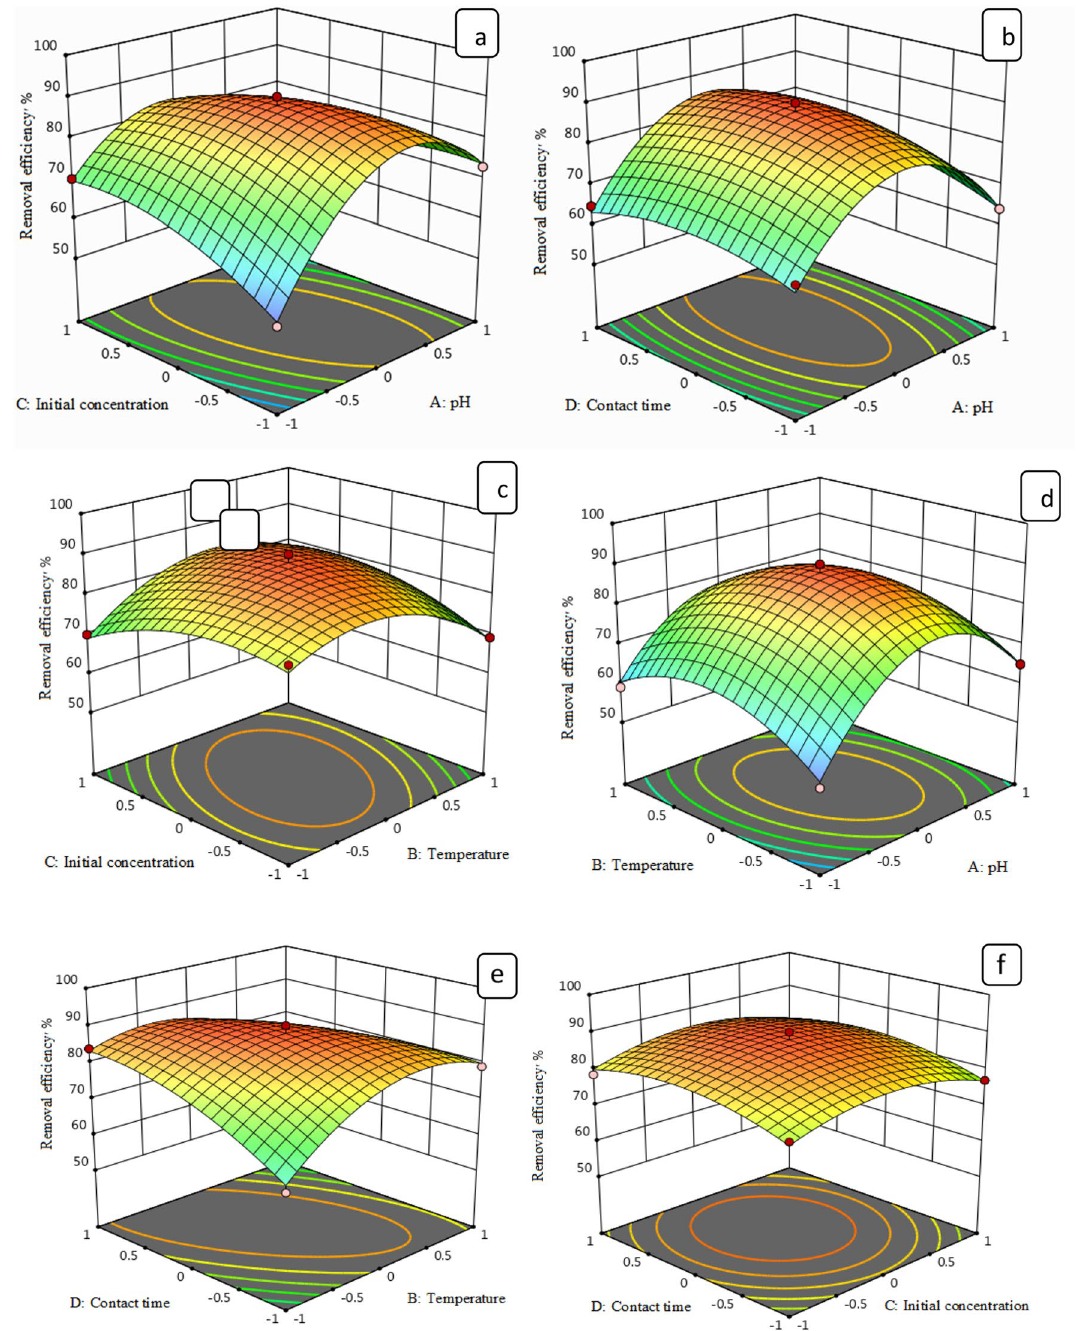
Figure 21. ( a ) the cumulative impact of pH and contact time, ( b ) the cumulative impact of pH and MG dye concentration, ( c ) the cumulative impact of pH and temperature, ( d ) the cumulative impact of contact time and MG dye concentration, ( e ) the cumulative impact of contact time and temperature, ( f ) the cumulative impact of temperature and MG dye